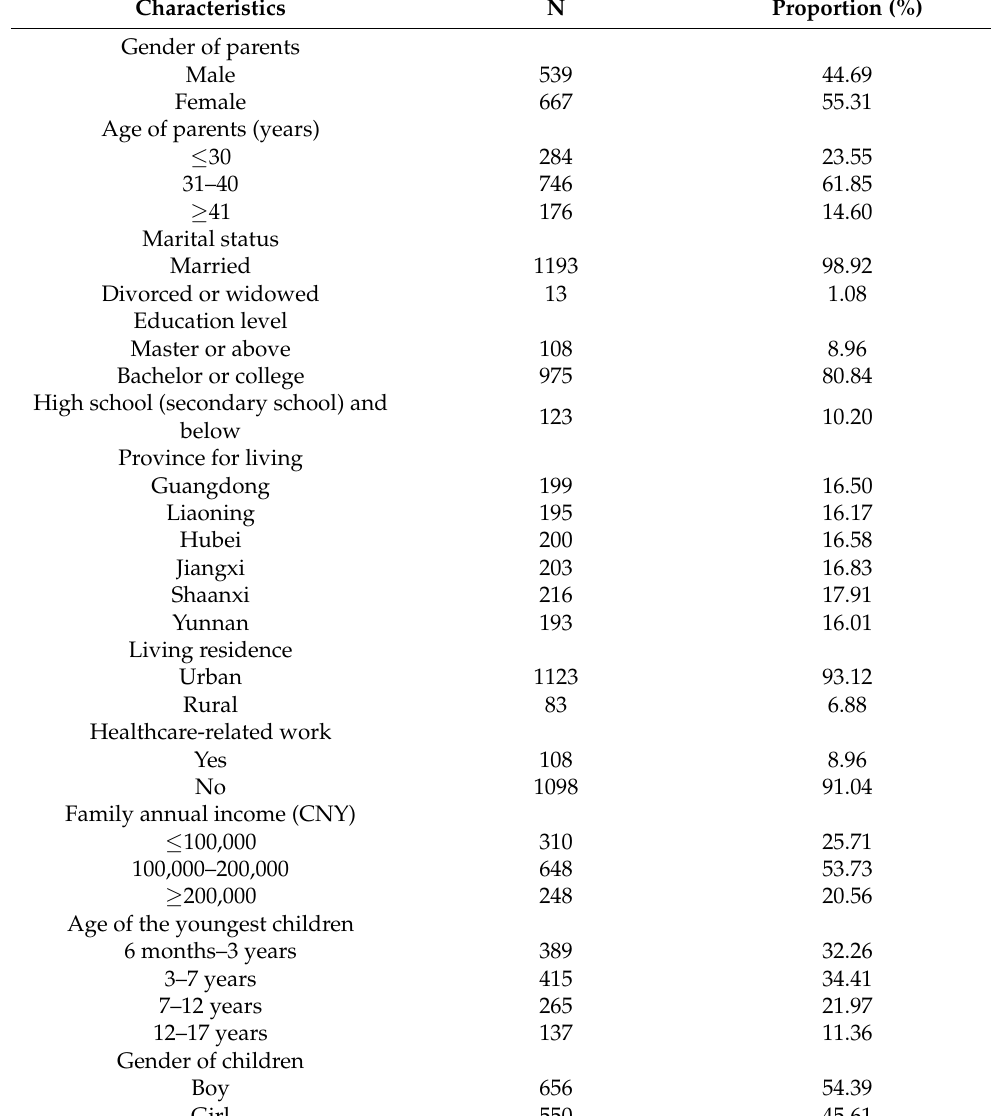
Table 2. Socio-demographic characteristics of all respondents (N =